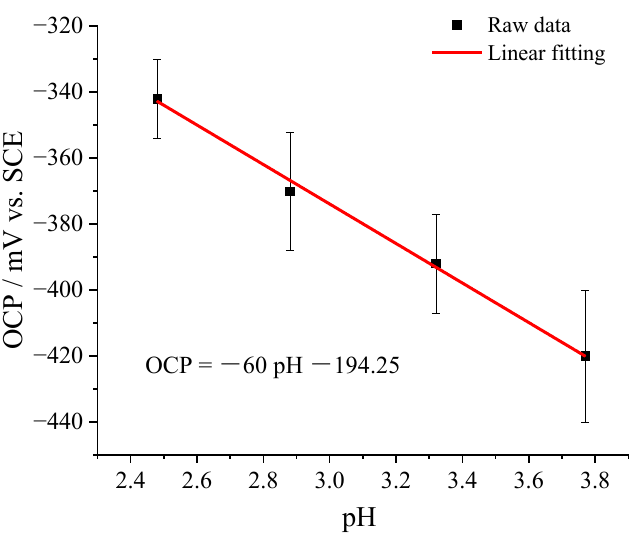
Figure 4. Plots of open circuit potentials and pH of SurTec 650 ChromitAL solutions with adding 5% H 2 SO 4 and 5% NaOH droplets with raw and fitted data as functioned as “OCP = − 60 pH — 194.25”.